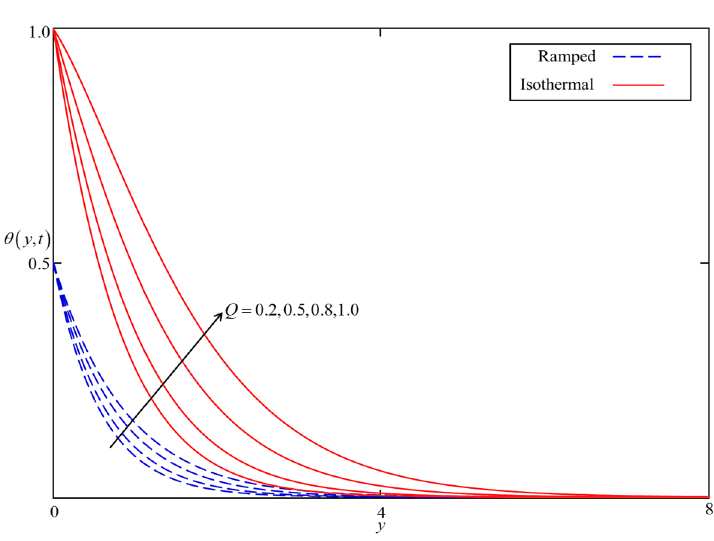
y , t when α = 0.5 , φ = 0.04 , β = 0.5 , M = 0.5 , Gr = 5 , Q = 0.5 and (cid:30) (cid:31)